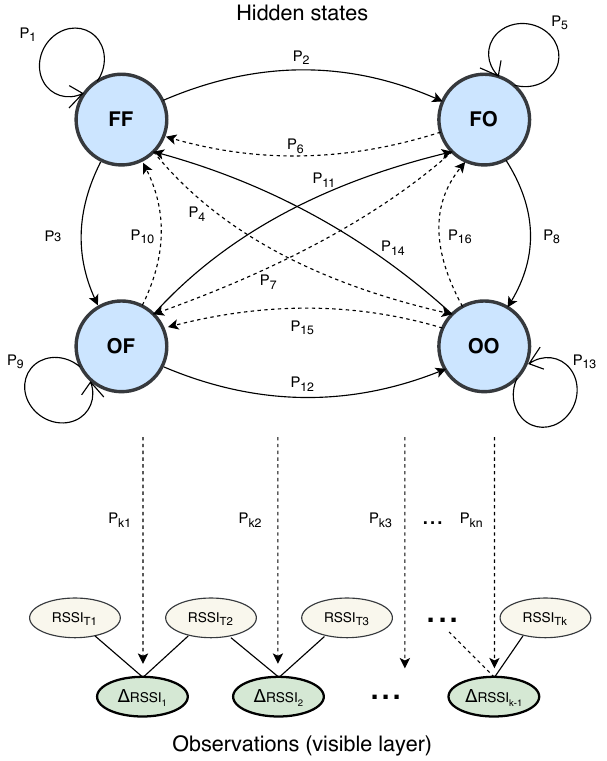
Figure 8. Illustration of second-order Hidden Markov Model for detecting occupancy status based on change of RSSI